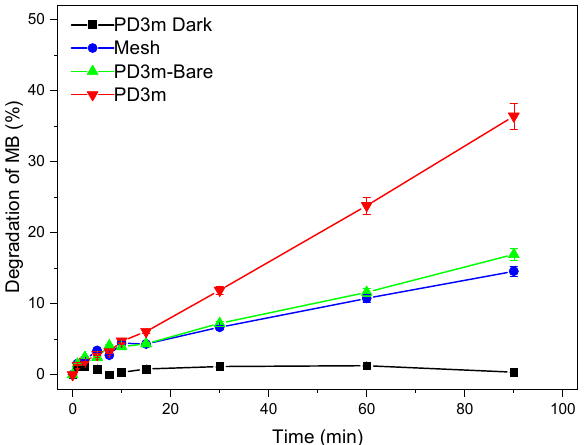
Figure 4. MB degradation experiments were monitored upon UV irradiation with the naked mesh (Mesh), the mesh coated with the organic matrix of the coating ( PD3m-bare ), and the PD3m coating ( PD3m ). For comparison, the experiment was also carried out while exposing the 3m coating to the dye solution in the dark ( PD3m Dark). The experimental data are reported as the mean values of three replicates ± standard deviations.